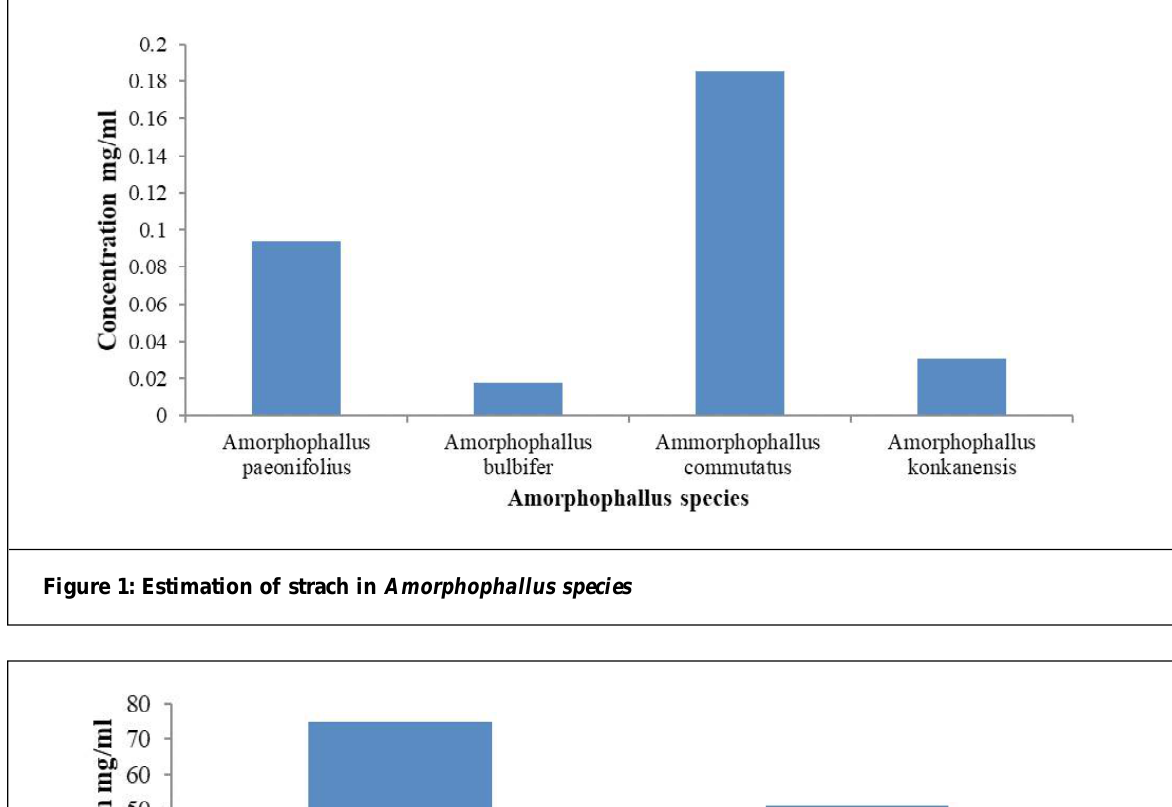
Figure 1: Estimation of strach in Amorphophallus species